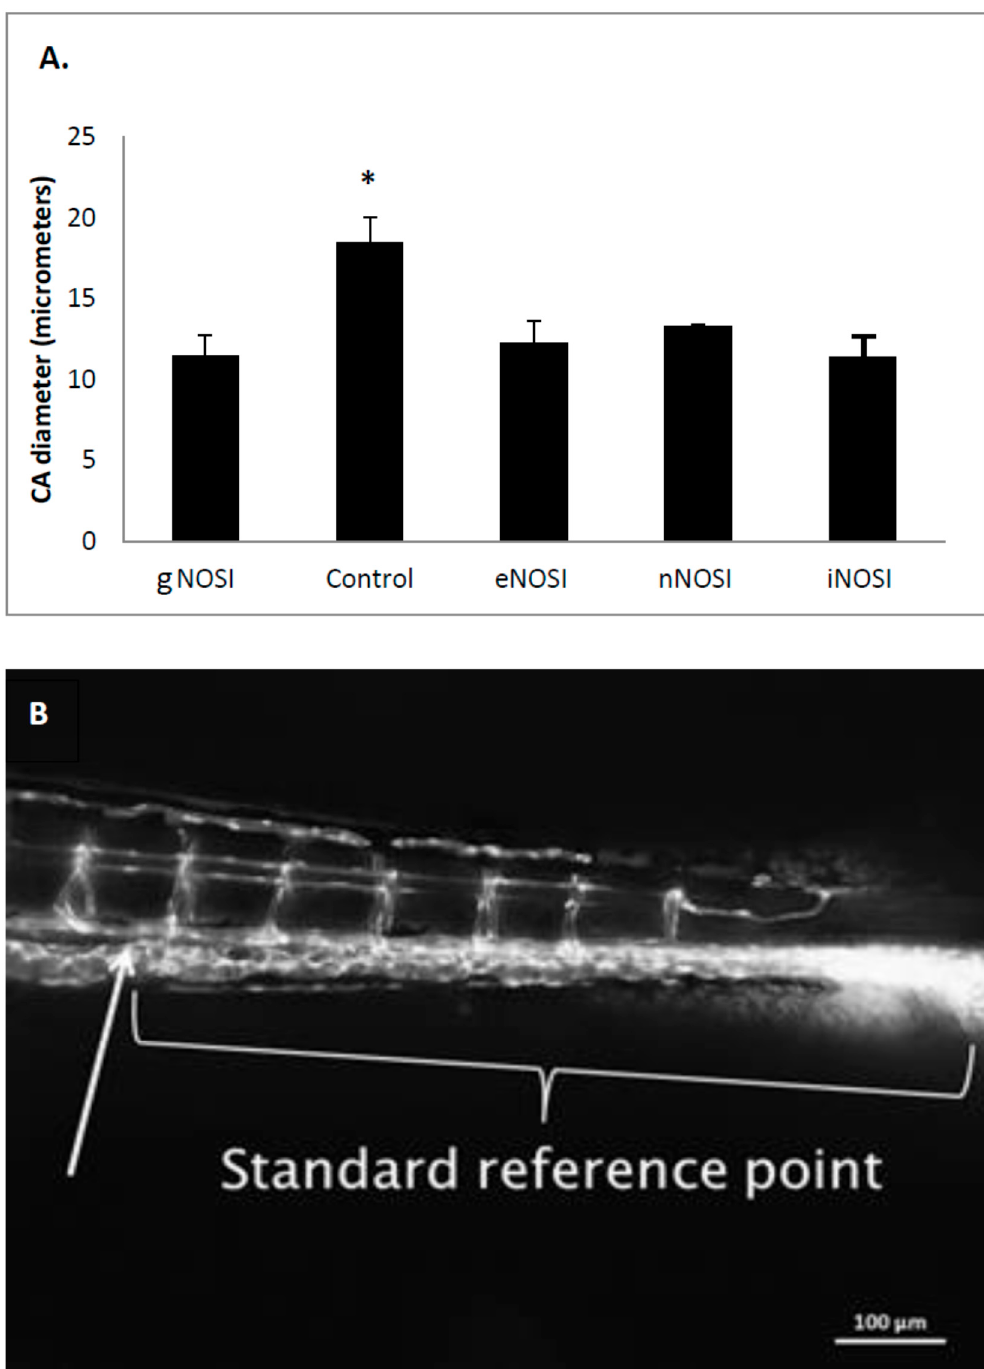
Figure 7. The effects of various treatments in TG(fli1:EGFP) y1/+y1 (AB) transgenic fish on average tail caudal artery (CA) diameter as measured from confocal z-stack photomicrographs after 4 days of treatment beginning at 48 h post fertilization (hpf). ( A ) CA diameter is significantly decreased in gNOSI treated fish when compared to that of controls (* p < 0.001). In addition, all three NOSI isoforms also cause a significant decrease in CA diameter ( p < 0.05; Bar = ± SD); ( B ) In order to ensure that measurements of all vessels including the CA were collected in the same location in every confocal- imaged photograph, a standard reference point (arrow) of a distance (875 µ m) from the tail region was used. Bar equals 100 μ m.